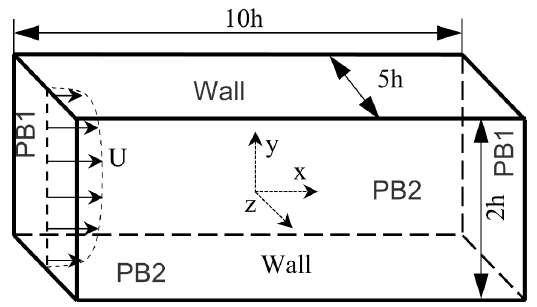
Figure 1. Domain for the viscoelastic flow in a channel. The front and back boundaries of the calculation domain are a pair of periodic boundary conditions, the left and right boundaries are a pair of periodic boundary conditions, and the upper and lower boundaries are walls. h is a half of the channel height.